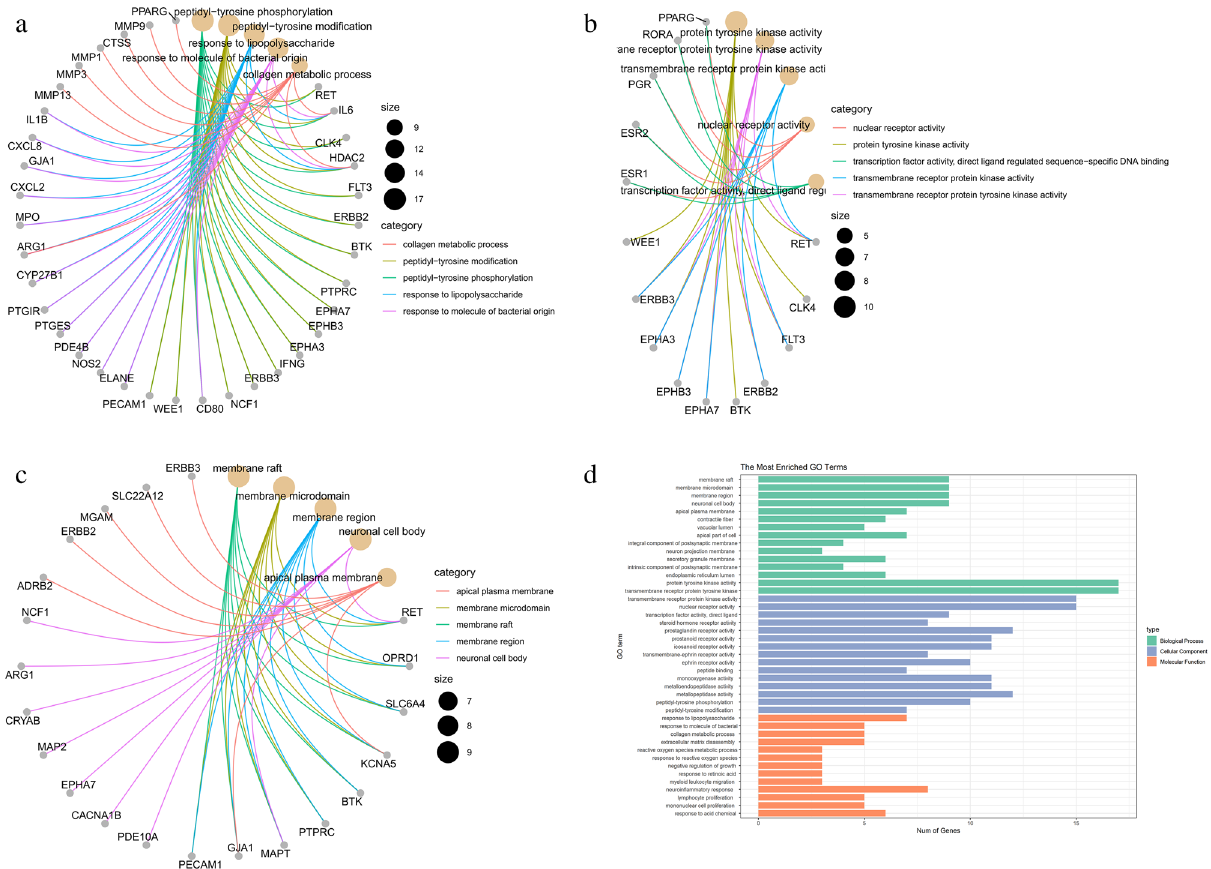
Figure 4. GO enrichment analysis of the anti-Peri-implants targets of PCRER. ( a ) Biological processes; ( b ) molecular function; ( c ) cellular components; ( d ) the 15 most enriched GO terms.